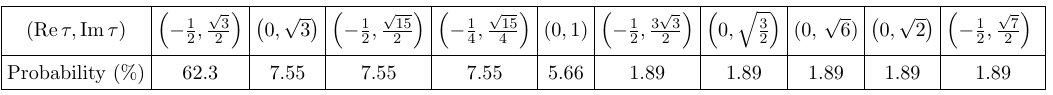
Figure 1 . The numbers of stable vacua on (Re (cid:28); Im (cid:28) ) plane for N max N max = 1000 in the right panel, respectively. (cid:13)ux